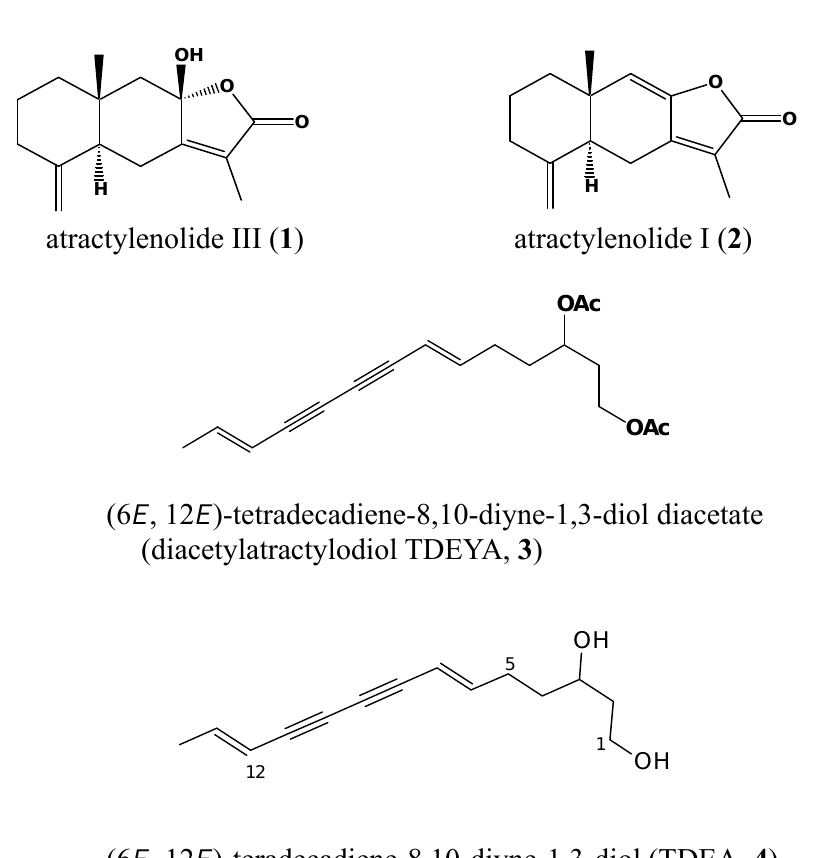
Figure 1. Chemical structures of isolated compounds from roots of A. japonica : atractylenolide III ( 1 ); atractylenolide I ( 2 ); (6 E , 12 E )-tetradecadiene-8,10-diyne-1,3-diol diacetate (diacetylatractylodiol TDEYA, 3 ); (6 E , 12 E )-tetradecadiene-8,10-diyne-1,3-diol (TDEA, 4